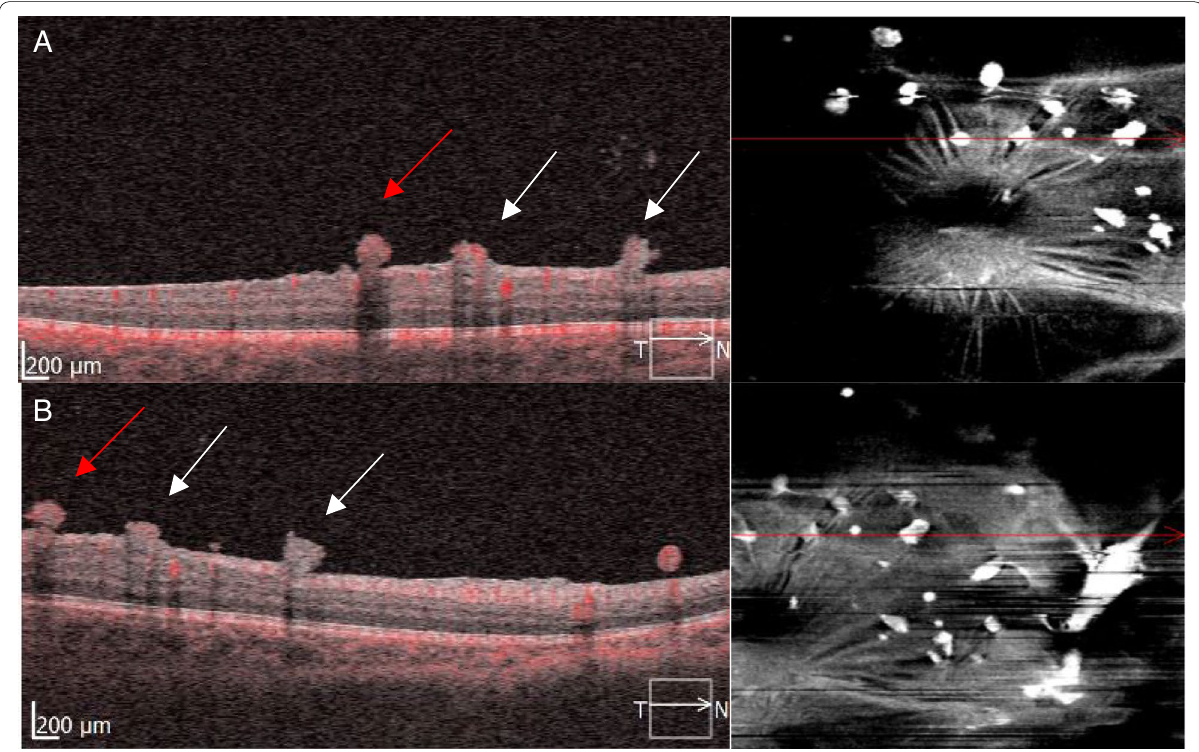
Fig. 5 OCTA at the time of initial treatment shows intrinsic flow signal through these macular ERN ( A ). After the last session of laser ablation, decreased flow signal was observed in some ERN lesions (white arrows) but flow persisted in others (red arrow) ( B